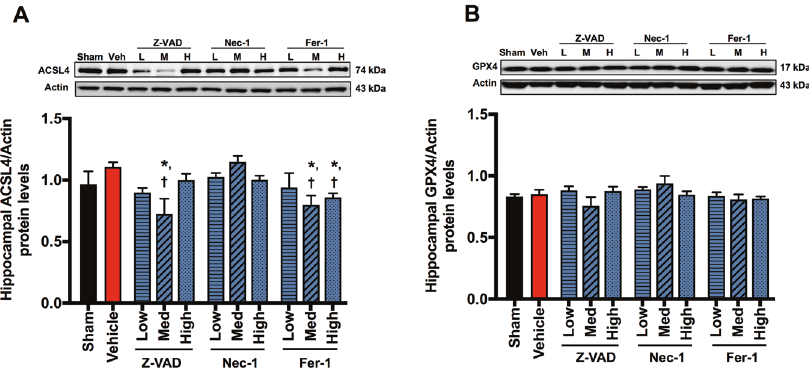
Fig. 6 The effects of cell death inhibitors on hippocampal ferroptosis signaling pathways. A ASCL4 protein expression; B Gpx4 protein expression. Data are shown as mean ± SEM. * P < 0.05 vs. Sham, † P < 0.05 vs. Cardiac I/R + Vehicle; n = 6/group. Veh: cardiac I/R rats treated with vehicle; L: cardiac I/R rats treated with low dose of cell death inhibitor; M: cardiac I/R rats treated with medium dose of cell death inhibitor; H: cardiac I/R rats treated with high dose of cell death inhibitor. I/R ischemia/reperfusion injury, ASCL4 acyl-CoA synthetase long- chain family member 4, Gpx4 glutathione peroxidase